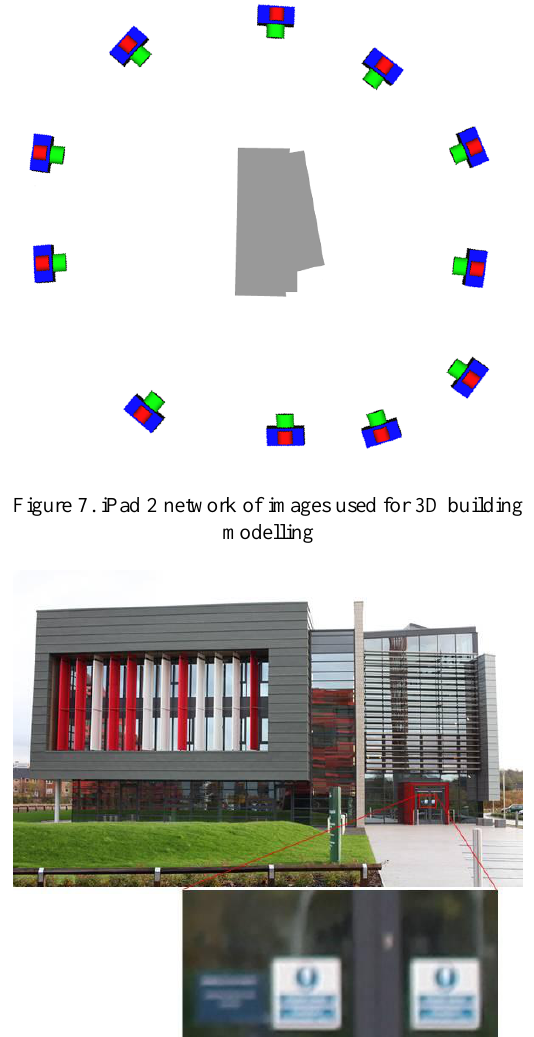
Figure 8, Building facade and image quality from the Canon